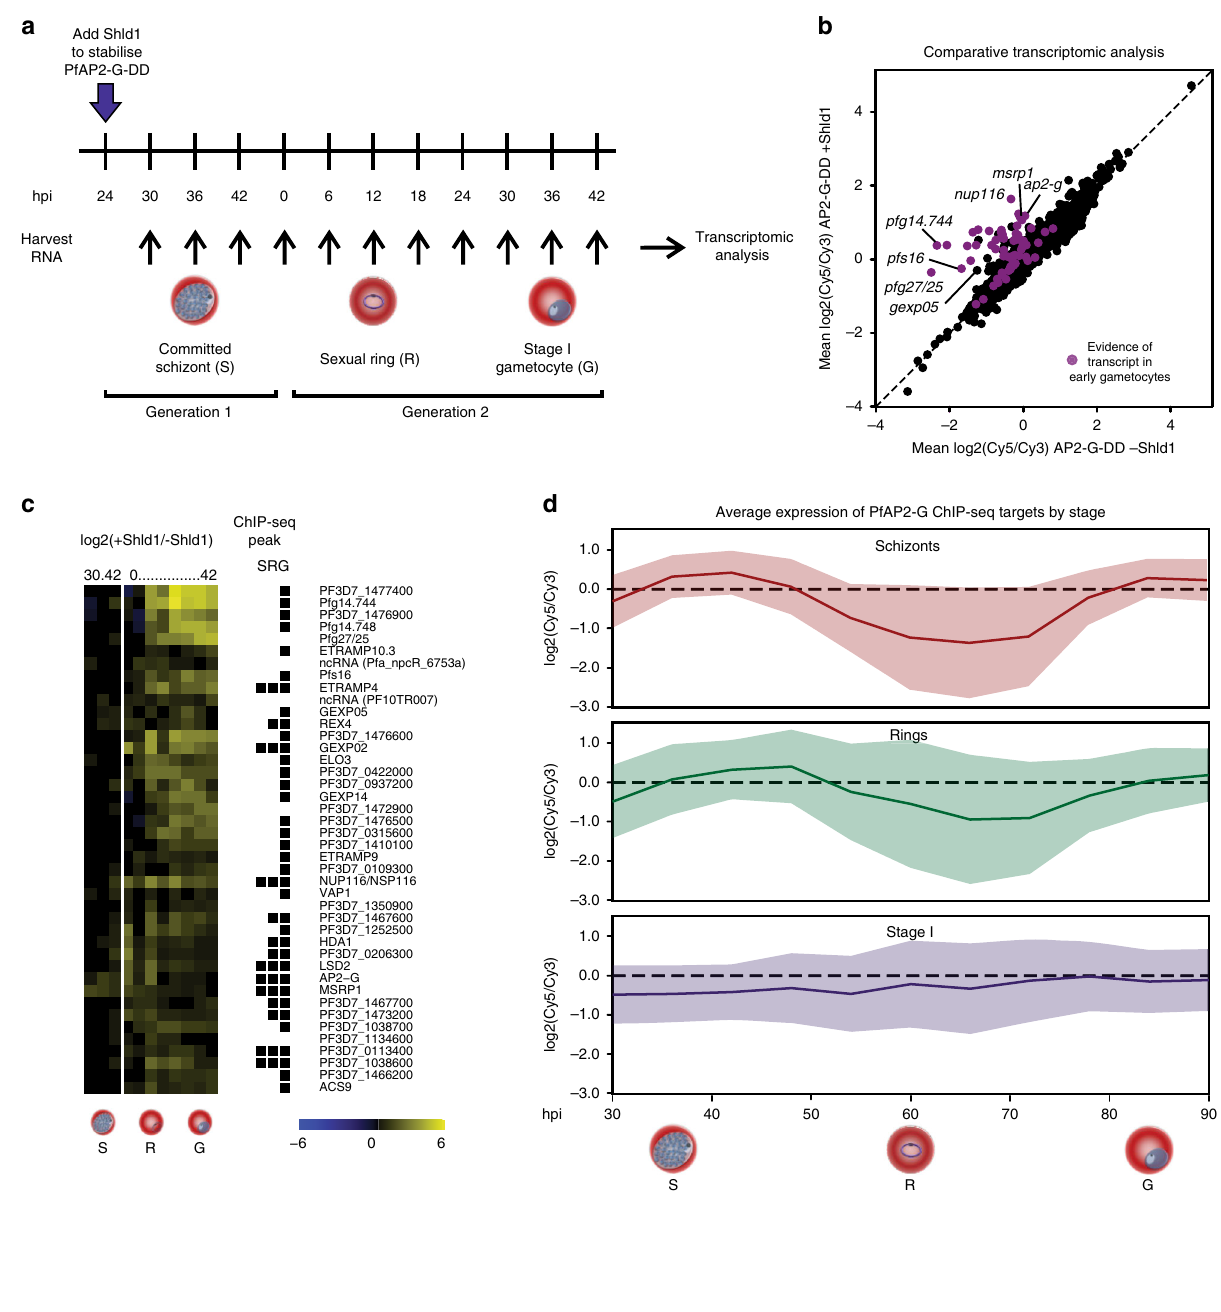
Fig. 3 PfAP2-G directly regulates many early gametocyte genes. a Schematic showing the design of the transcriptomic timecourse using AP2-G-DD. The AP2-G-DD line8, which allows for conditional stabilisation or degradation of PfAP2-G depending on the presence of Shld1, was used to identify PfAP2-G target genes. Transcript levels were compared in parallel cultures grown in the presence and absence of Shld1. The timecourse included committed schizonts (S), sexual rings (R), and stage I gametocytes (G). b Scatterplot showing mean expression of all transcripts in AP2-G-DD + Shld1 versus AP2-G- DD -Shld1. Transcripts that have been identi fi ed in committed schizonts and early gametocytes13,18,20,27are in purple. Several genes of particular interest are highlighted. c Heatmap showing expression of signi fi cantly differentially expressed transcripts (FDR ≤ 0.1 using Signi fi cance Analysis of Microarrays, fold change ≥ 1.5) over time in AP2-G-DD + Shld1 compared to AP2-G-DD -Shld1. The black squares to the right indicate whether or not the gene has a ChIP-seq peak upstream of it in each of the three stages tested. d Plot showing mean temporal expression of schizont, ring, and stage I gametocyte ChIP- seq targets in the AP2-G-DD line + Shld1. The shaded area indicates the standard deviation. Differences in expression of the three sets of target genes were tested by two-way ANOVA (schizonts vs. rings: p = 0.0097, schizonts vs. stage I: p < 0.0001, rings vs. stage I: p < 0.0001). Source data are provided as a Source Data fi